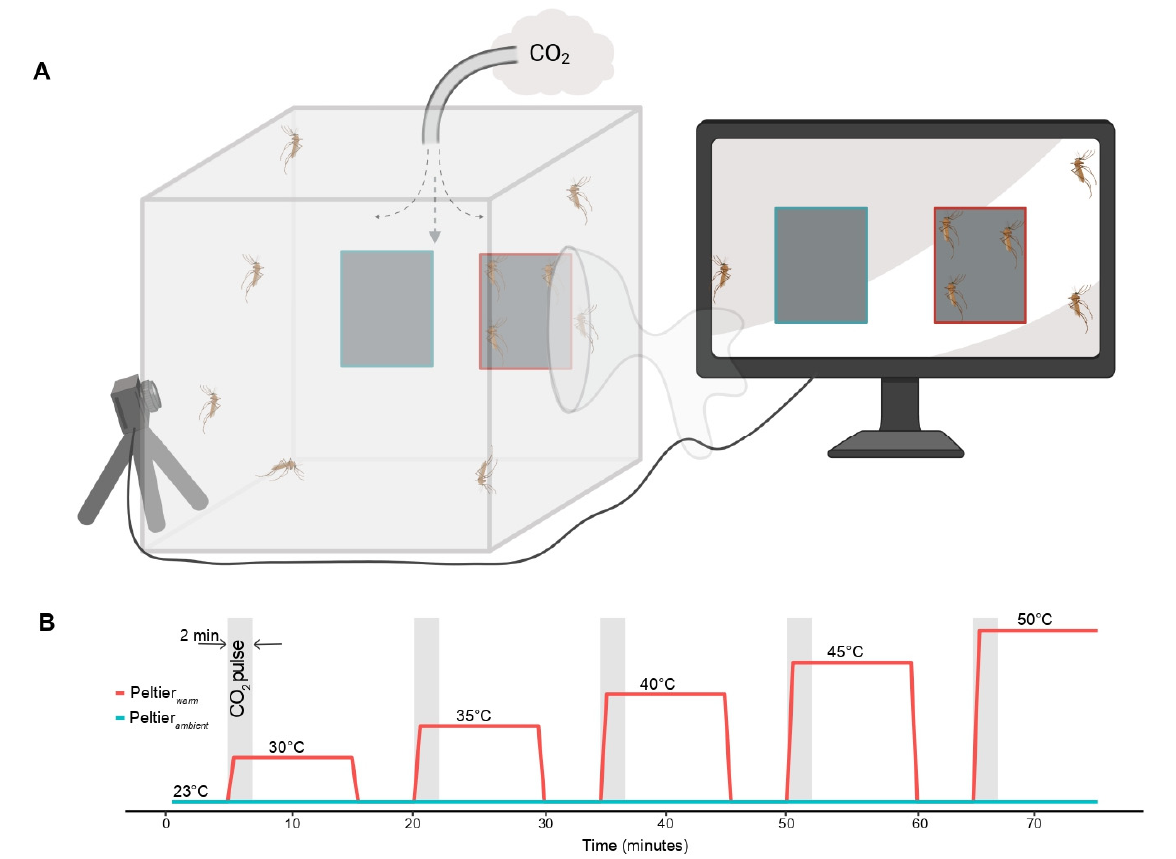
Figure 2. ( A ). Schematic of the heat-seeking experimental setup. Mosquitoes were released into a meshed cage with two Peltier elements directly applied to one side: one maintained at ambient temperature (23 °C, outlined in blue), and one set up to warm up as described in ( B ). A camera recorded the landing activity on the Peltier elements. Through the top of the cage, a tube delivered a constant flow of humidified air to which pulses of CO 2 were added as described in ( B ). ( B ). Schematic of ramping temperature steps of the “warm” Peltier element. The warm Peltier element was brought to ambient temperature (2 min) between each step (8 min), which increased the temperature by 5 degrees. Each step began with a 2-min pulse of CO 2 (in gray).